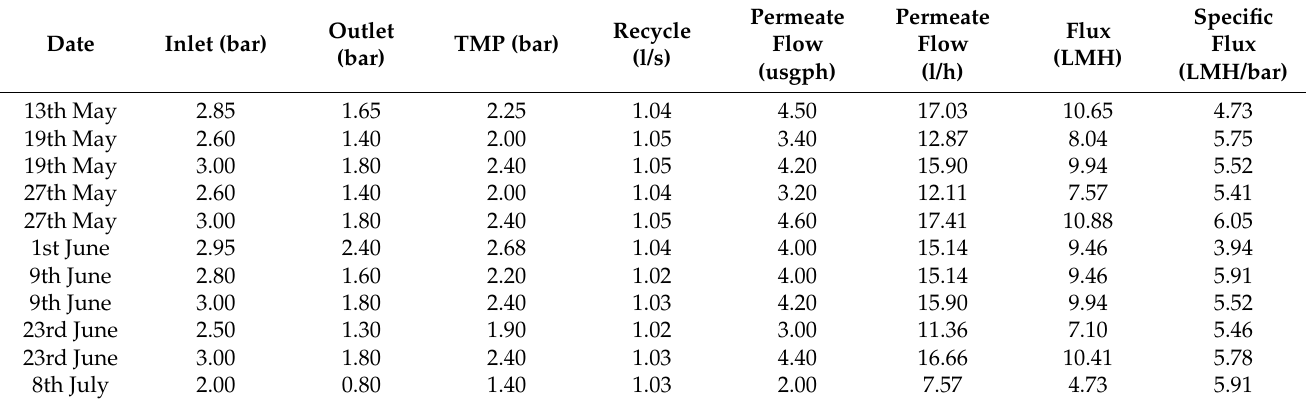
Table 8. Nanofiltration membrane performance data.